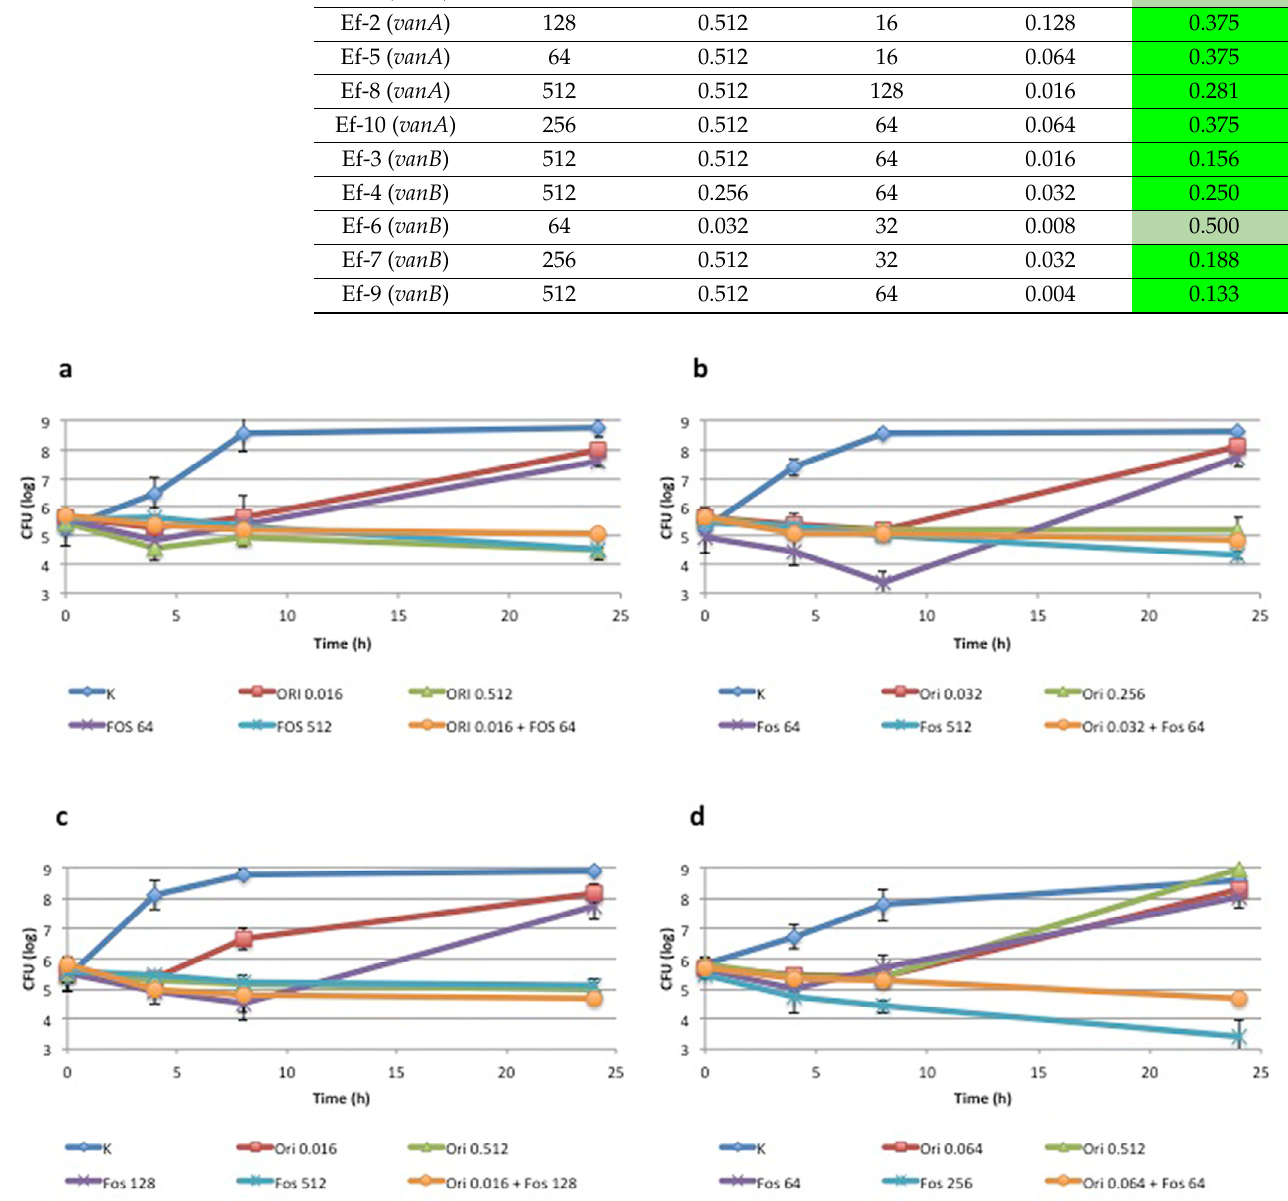
Figure 1. Time-kill curves showing log 10 CFU/mL at different times (mean) for ( a ) Ef-3 ( vanB ), ( b ) Ef-4 ( vanB ), ( c ) Ef-8 ( vanA ) and ( d ) Ef-10 ( vanA ). Results are the means ± standard deviation of three independent experiments.